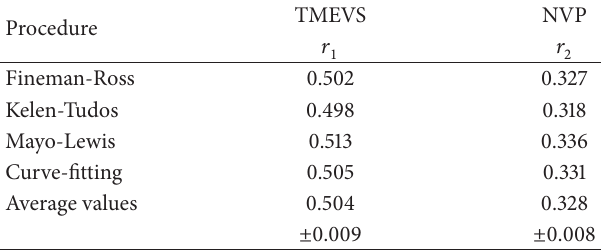
Figure 6: Copolymer composition of TMEVS/NVP. The black solid line represents the theoretical curve calculated from the copolymer composition equation for 𝑟 1 = 0 .505 and 𝑟 2 = 0.331 , which follows closely the experimental copolymer composition data that is mentioned by red circle colour. Table 4: Monomer reactivity ratios of TMEVS/NVP copolymer.